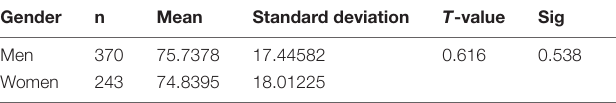
TABLE 5 | ANOVA: differences among the participants based on teaching experience.